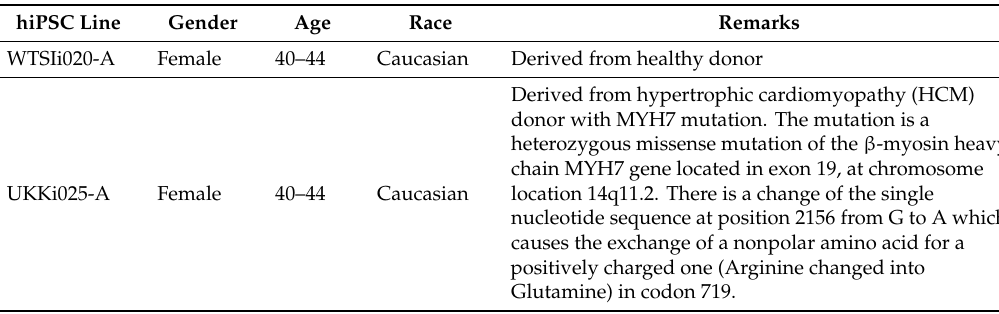
Table 1. Human induced pluripotent stem cell (hiPSC) lines obtained from the European Bank of Induced Pluripotent Stem Cells